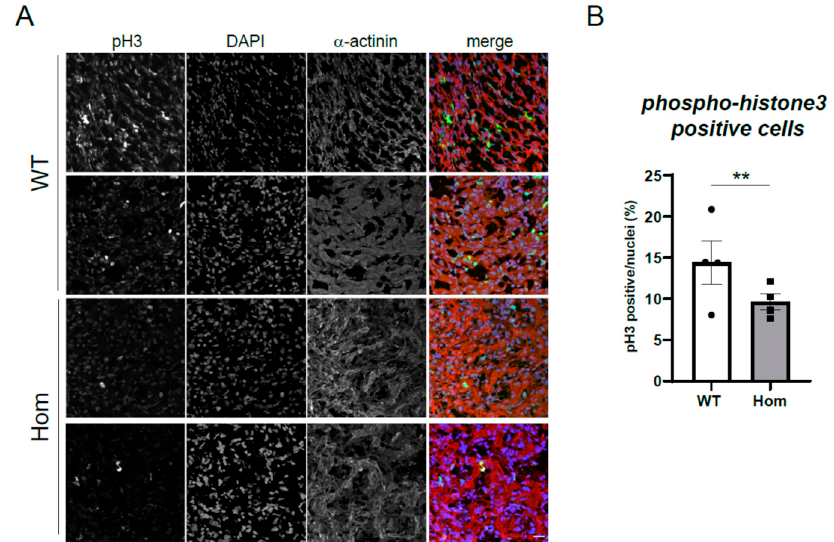
Figure 5. Cell cycling defects in E15.5 Hom hearts. ( A ) Cryosections of WT and Hom hearts were stained for cell proliferation marker phospho-histone H3 (pH3), sarcomeric alpha-actinin and nuclei were visualized with DAPI. Merged images show pH3 in green, DAPI in blue and alpha-actinin in red. Scale bar represents 20 microns. ( B ) Quantification of pH3 positive nuclei as a percentage of total nuclei (DAPI) is significantly reduced in E15.5 Hom hearts. ** p < 0.01 (nested ANOVA). Each data point represents the average value for one heart, with a total of 21 images from 4 WT hearts and 22 images from 4 Hom hearts analyzed.